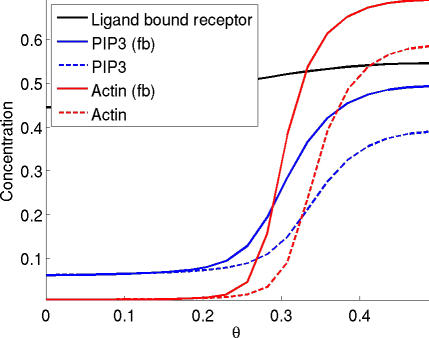
The Effect of a Positive Feedback Loop Involving PIP3 on PIP3 (Blue) and Actin (Red) Back-to-Front LocalizationThe model was simulated with the autocatalytic PIP3 reaction (fb, solid lines) and without (dashed lines). The ordinate is molecular concentration and the abscissa is the position on the membrane (θ).